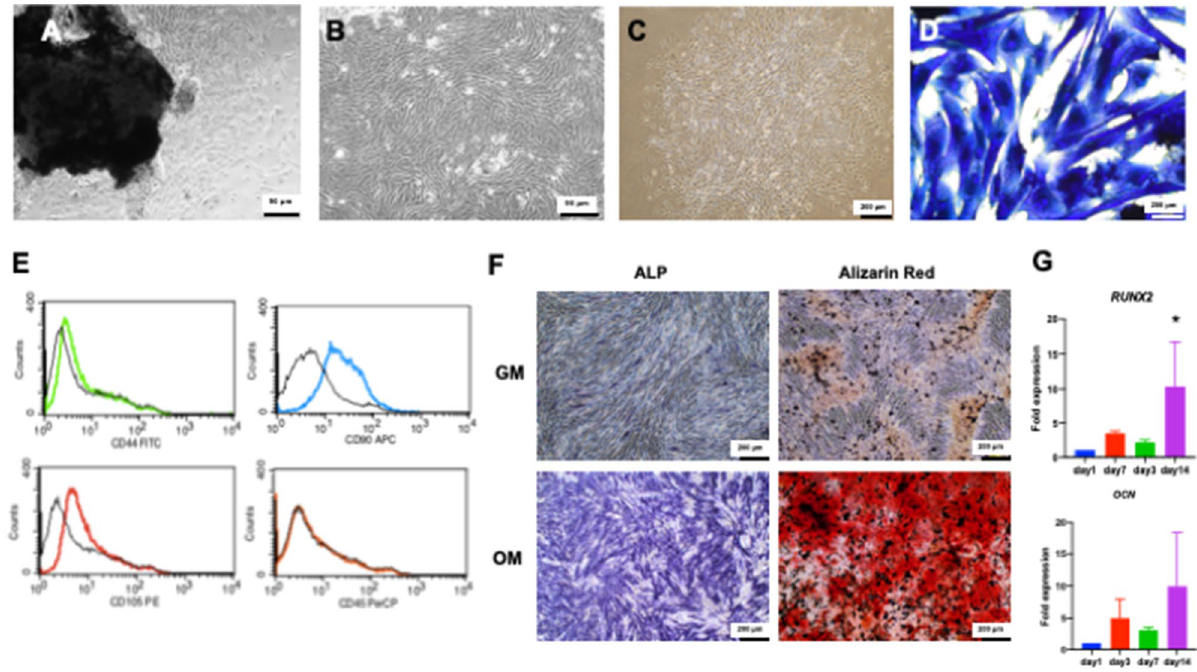
Figure 2. Characterization of canine periodontal ligament cells (cPDLs). cPDLs were isolated using cell explantation. Cell migration out from the tissue was observed at day 14 ( A ). These cells exhibited fibroblast morphology ( B ) and able to form colonies ( C ). Colonies were stained with Coomassie blue to present the homogeneous cell morphology ( D ). The isolated cells expressed CD44, CD90, and CD105 but not CD45 as red s staining, respectively ( F ). GM; growth medium, OM; osteogenic induction medium. The upregulation of osteogenic marker gene expression was investigated using real-time PCR ( G ). Asterisks indicated the